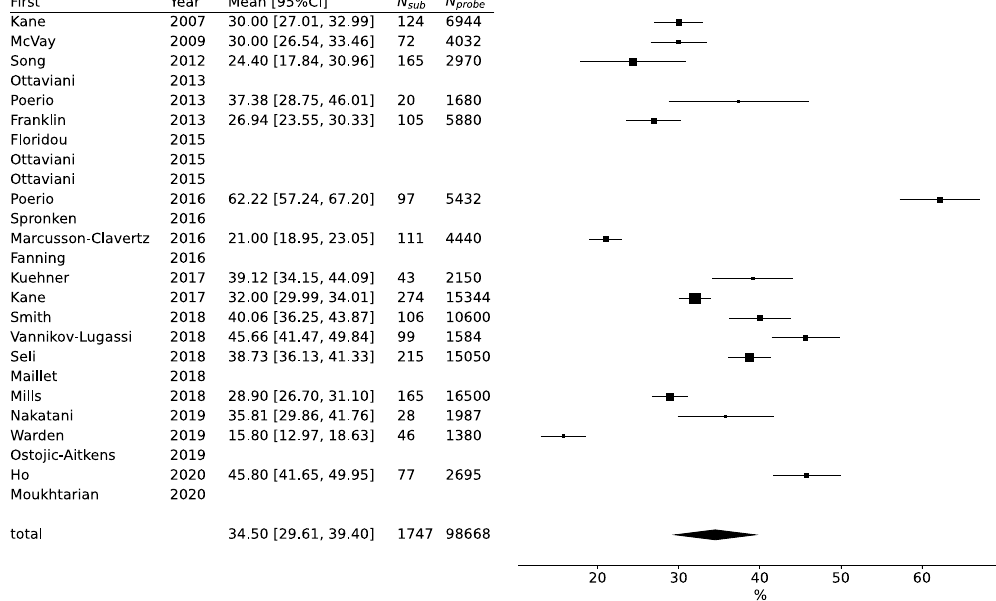
Figure 3. Forest plot of mind-wandering rate. The effect size and corresponding bar were blank if the mean MW rate was unavailable. First First author of studies, Year Year of publication, Mean [95%CI] , Reported mean MW rate and 95% confidence intervals, N sub Included number of subjects, N probe Included total number of probes.